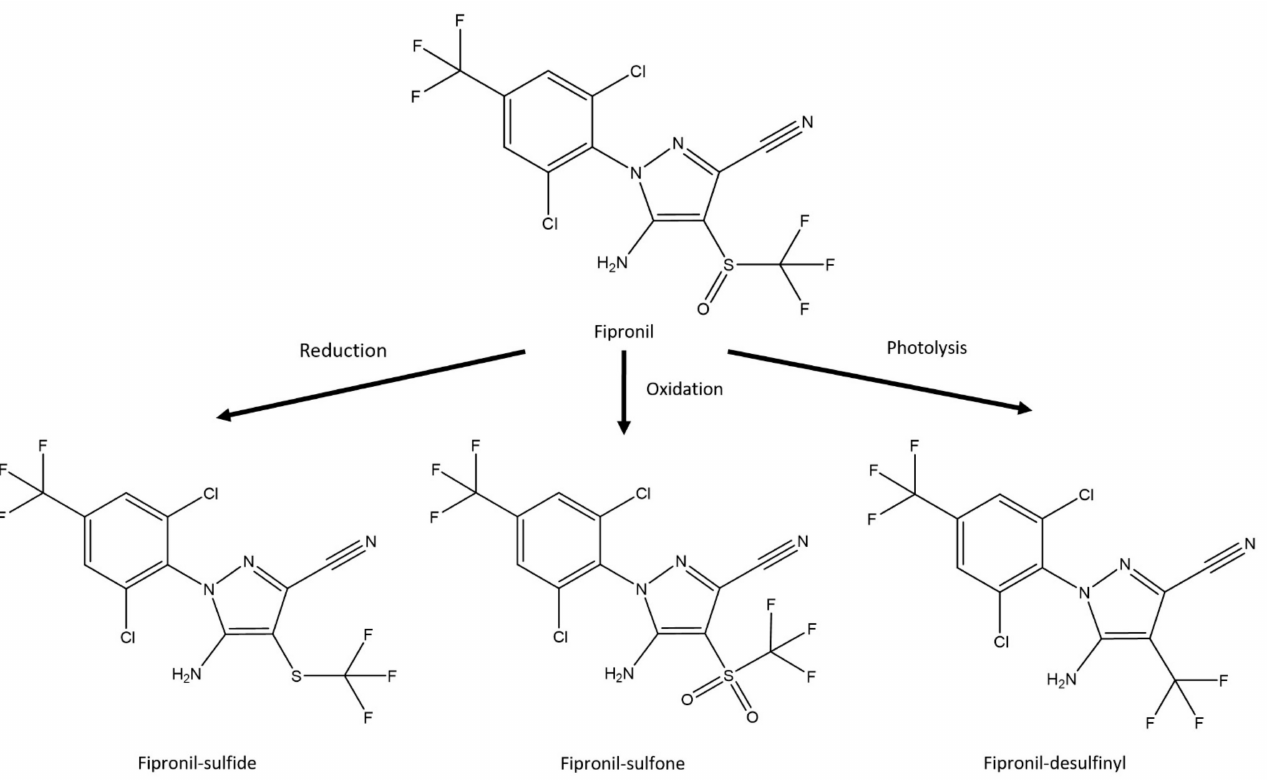
Figure 4. The degradation of fipronil to fipronil sulfide, fipronil sulfone, and fipronil desulfinyl occurs via reductive, oxidative, and photolytic mechanisms,